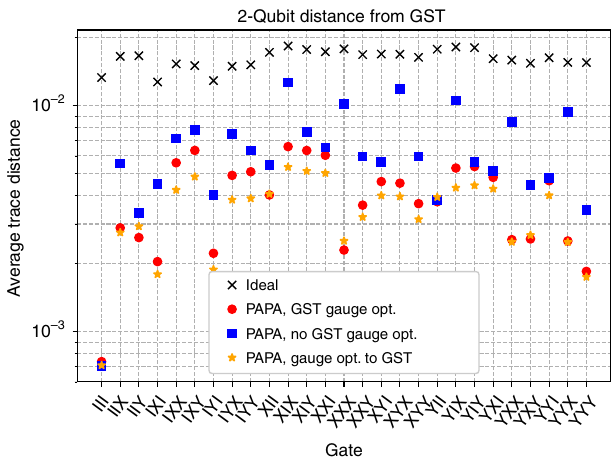
Fig. 6 Comparison of the GST measured process matrices to the ideal process matrices, and to a variety of PAPA reconstructions of the experimental data. Red circles are the data points from Fig. 3 with GST gauge optimization, and blue squares have no GST gauge optimization. Orange stars have a further round of gauge optimization performed between the PAPA reconstructions and the GST measured process matrices. As in Fig. 3, PAPA data points are the average trace distance of the three reduced processes from there corresponding GST